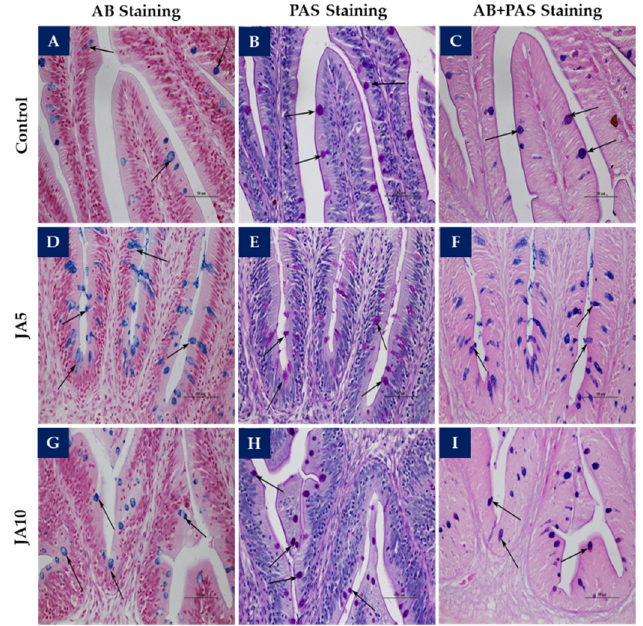
Figure 1. The proximal intestinal goblet cells ( arrows ) of red tilapia fed the control ( A – C ) , JA5 ( D – F ) , and JA10 diets ( G – I ) after special staining into three types: AB staining ( A , D , and G ) , PAS staining ( B , E , and H ) , and AB - PAS double - staining ( C , F , and I ). Bar 50 µm. AB: Alcian Blue; PAS: Periodic acid-Schiff. Table 5. Average number of goblet cells for red tilapia fed experimental diets for 4 weeks.